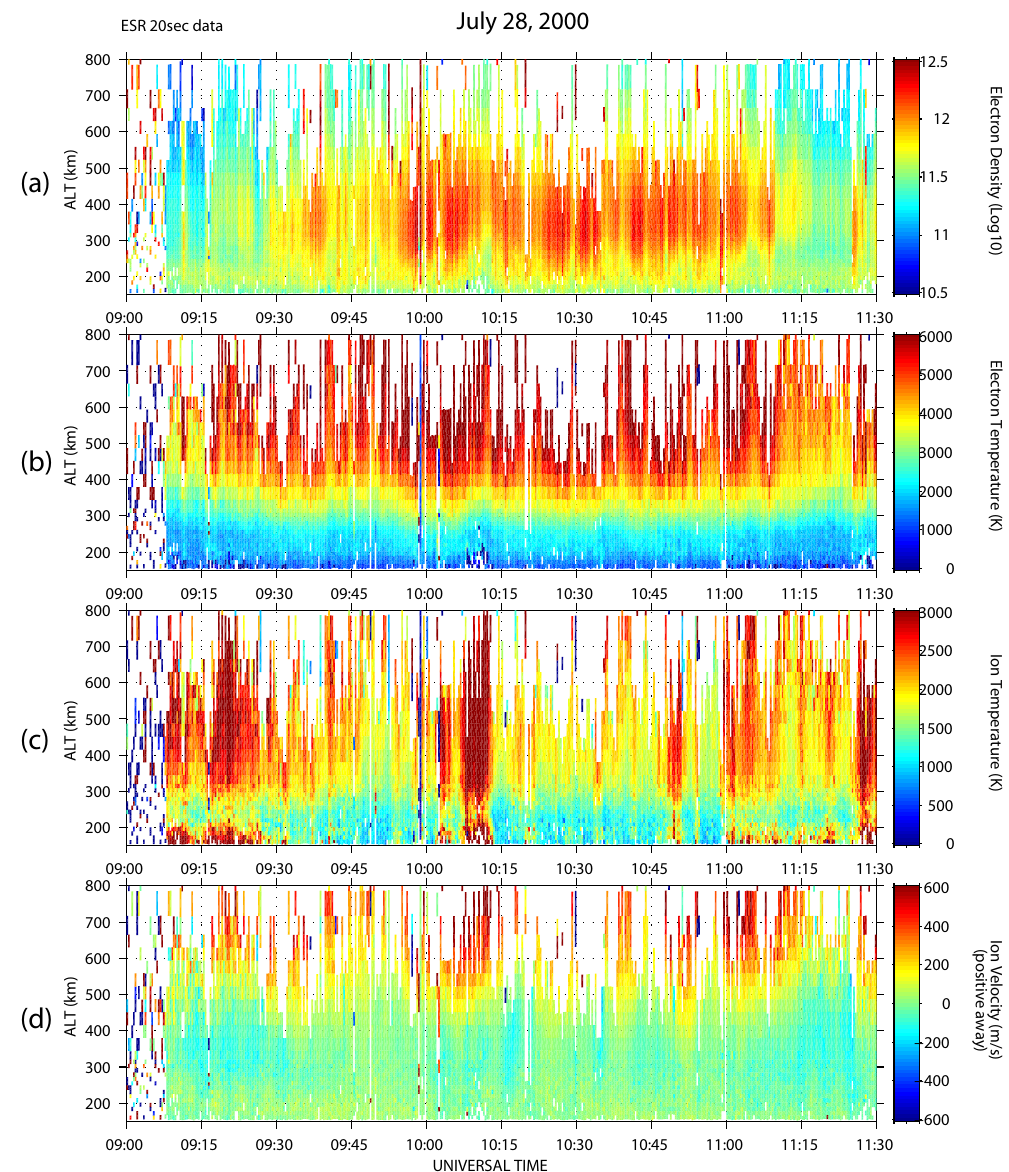
Fig. 4. Fig. 4. Color-coded height-time profiles of 20s integrated data obtained by the ESR between 09:00 and 11:30 UT on 28 July 2000. They are, from top to bottom: electron density, electron and ion temperatures, and the magnetic field aligned velocity, respectively.